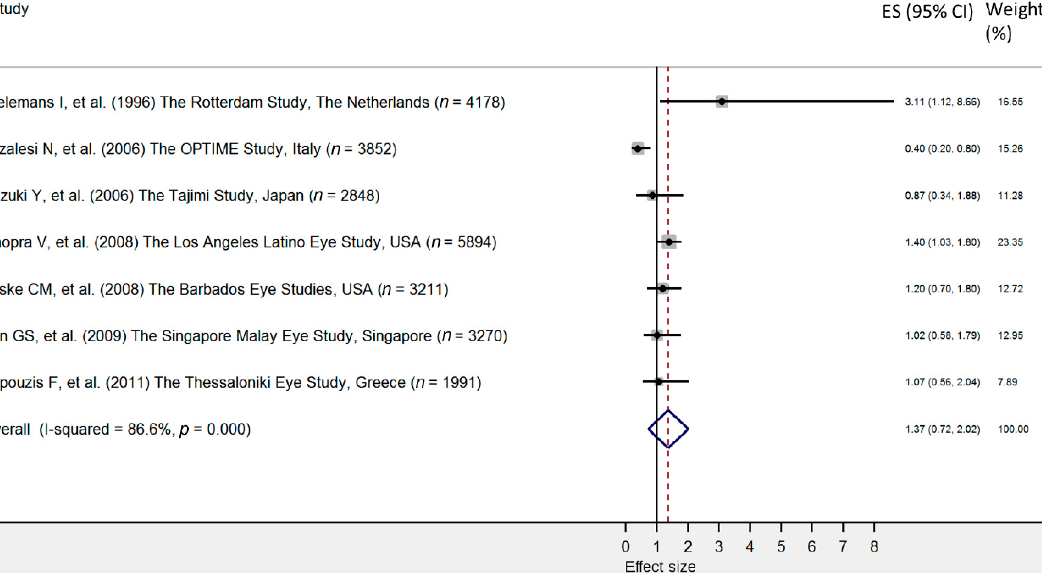
Figure 3. Forest plot of cohort studies that evaluated diabetes as a risk factor for primary open angle glaucoma. The effect size (square, with size proportional to weights used) and 95% confidence intervals (horizontal lines) is presented for each study. The overall measure revealed by pooled analysis is marked with the center of the diamond, while the associated confidence intervals are marked by lateral tips of diamond [31,32,34,42,46,49,51].